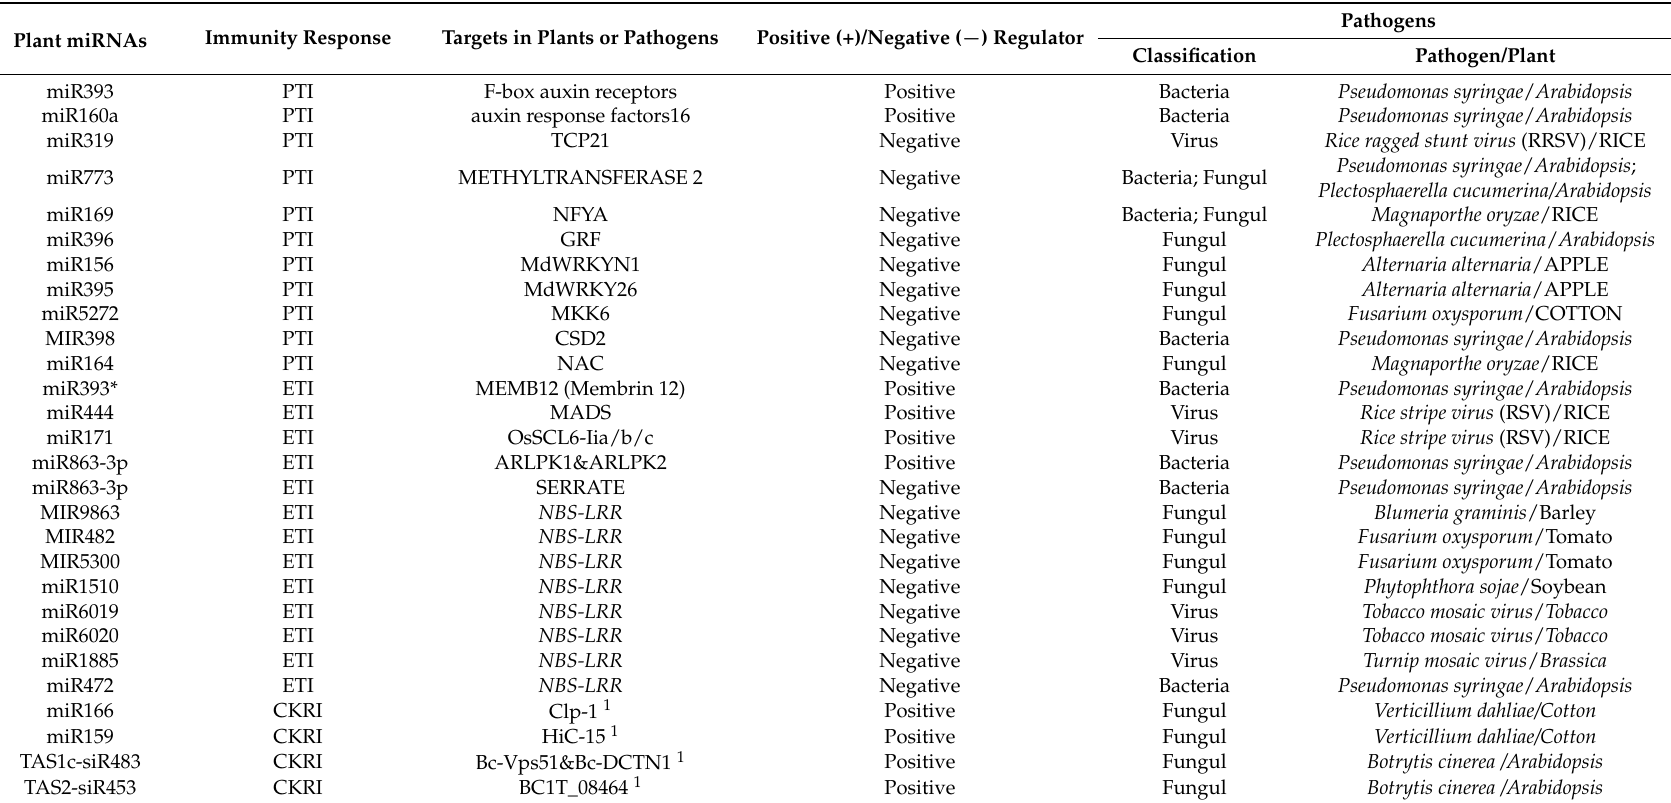
CKRI: Cross-kingdom RNA interference; 1 Target gene from